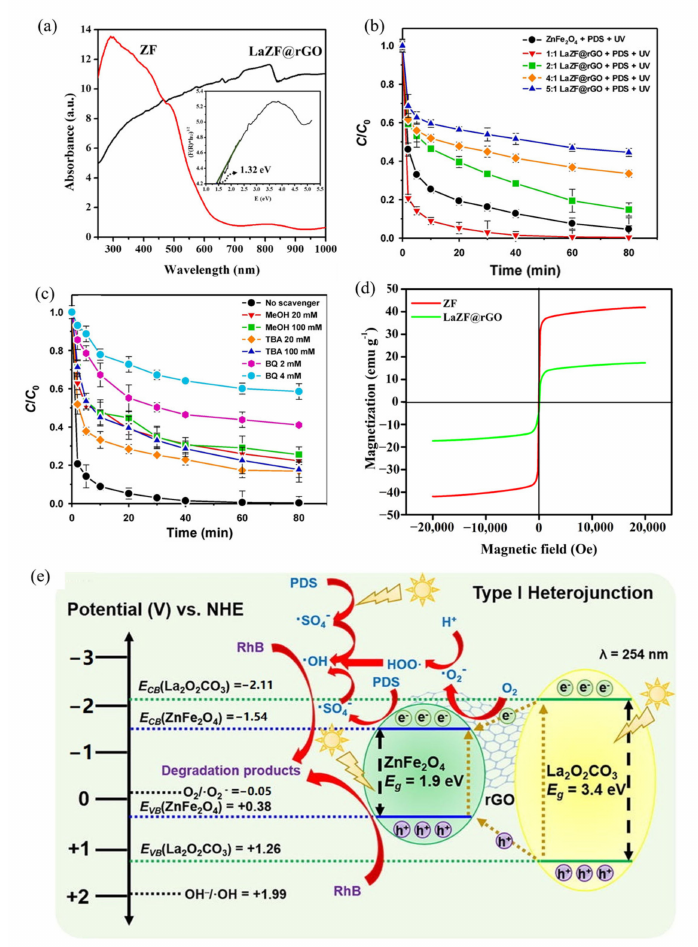
Figure 13. ZnFe 2 O 4 and LaZF@rGO: ( a ) UV-Vis absorption spectra; ( b ) influence of La content in LaZF@rGO; ( c ) radical scavengers on RhB decolorization; ( d ) Magnetization curve; ( e ) a schematic representation of the RhB degradation mechanism [108] (reprinted with permission from [108] Jun et al.,